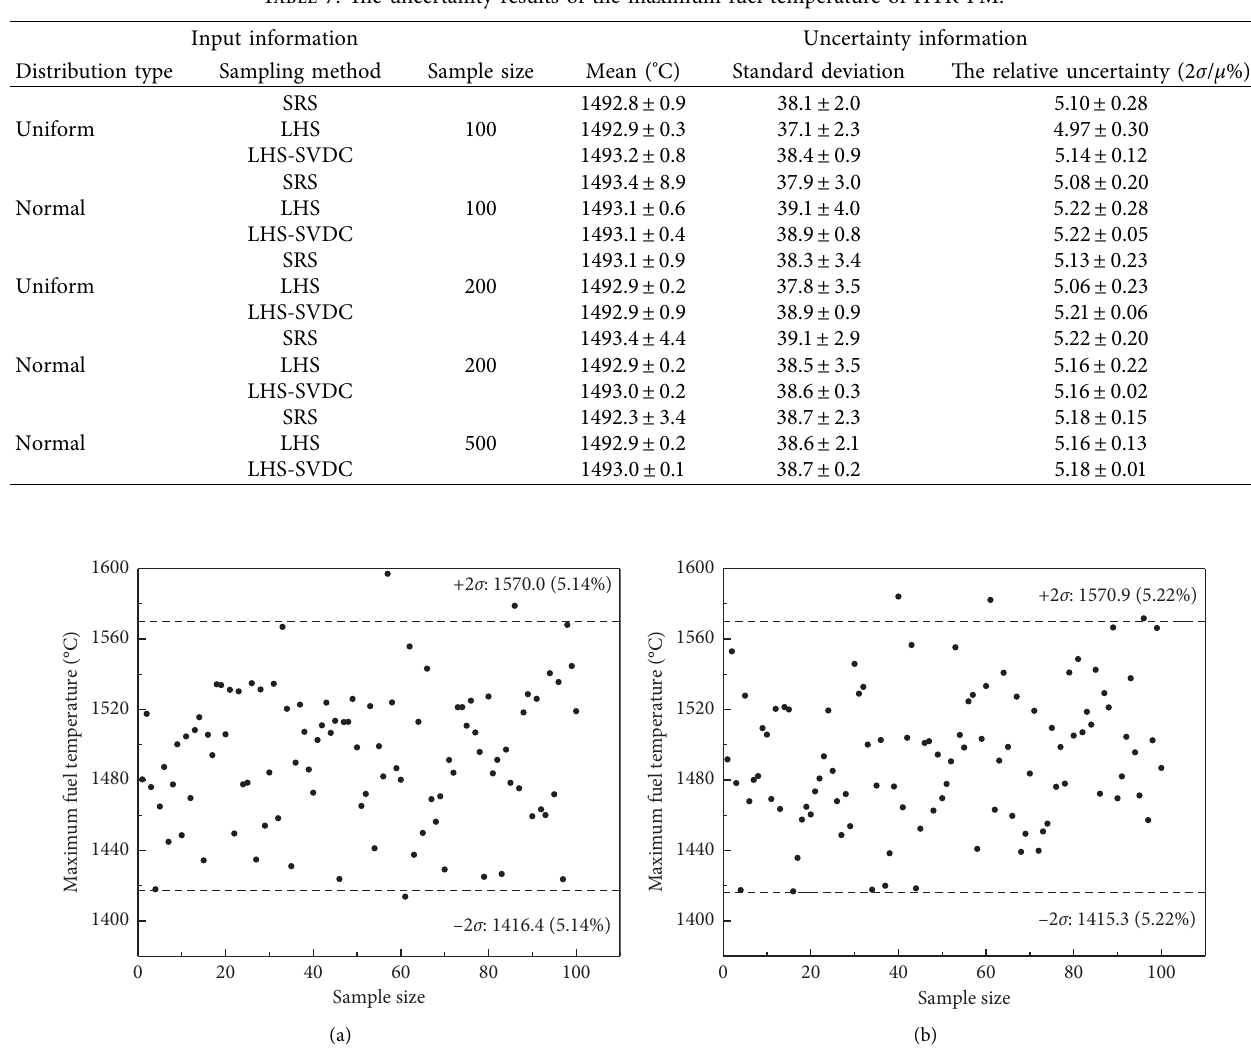
Table 7: The uncertainty results of the maximum fuel temperature of HTR-PM.